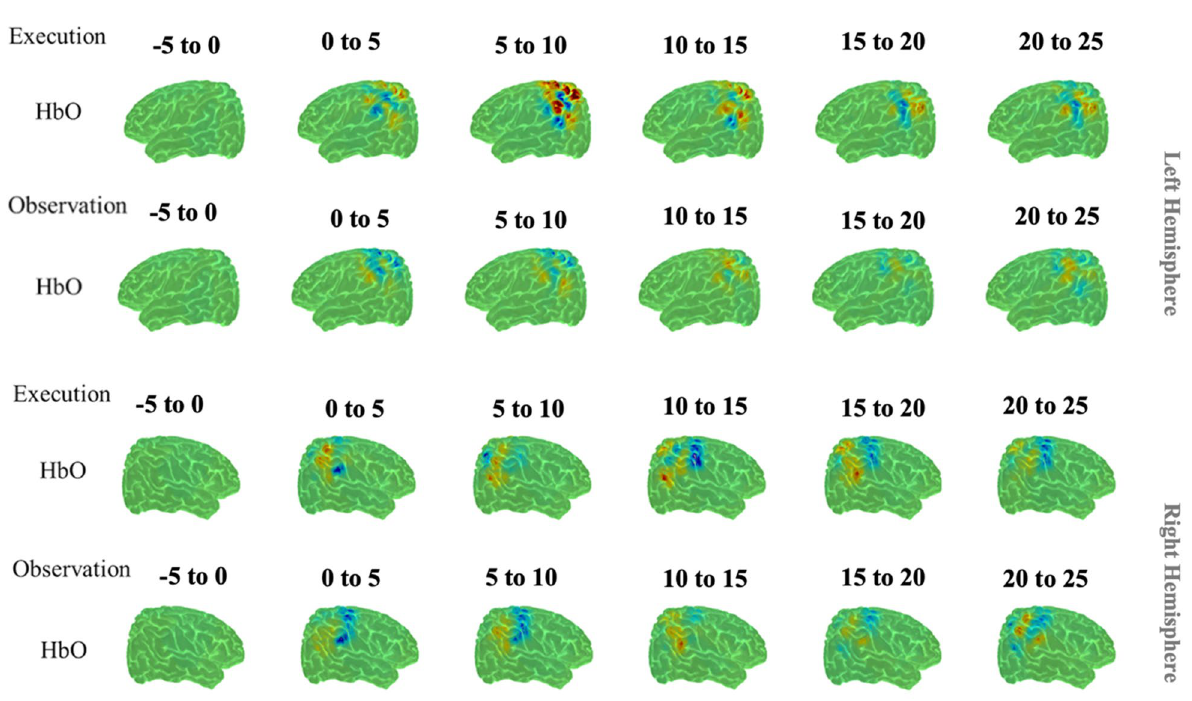
Figure 3. Unimodal fNIRS results. HbO reconstruction maps for Execution and Observation in the Left and Right Hemisphere from − 5 to 25 s. Overall, our results showed the parietal regions, including bilateral superior parietal lobule, bilateral inferior parietal lobule, right supra-marginal region and right angular gyrus are candidate regions of the human AON 53